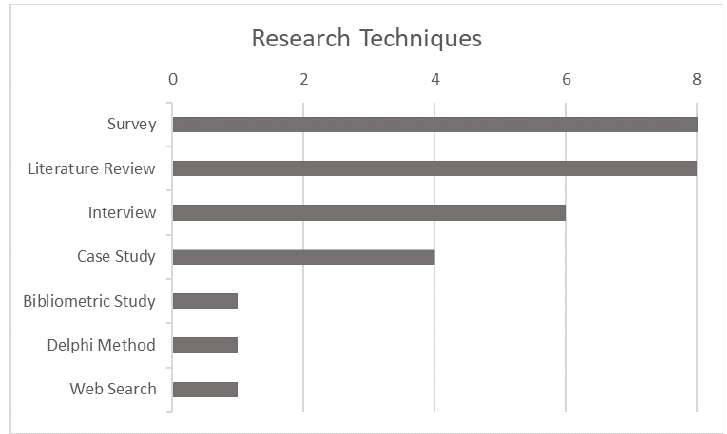
Figure 3. Research Techniques in the Literature